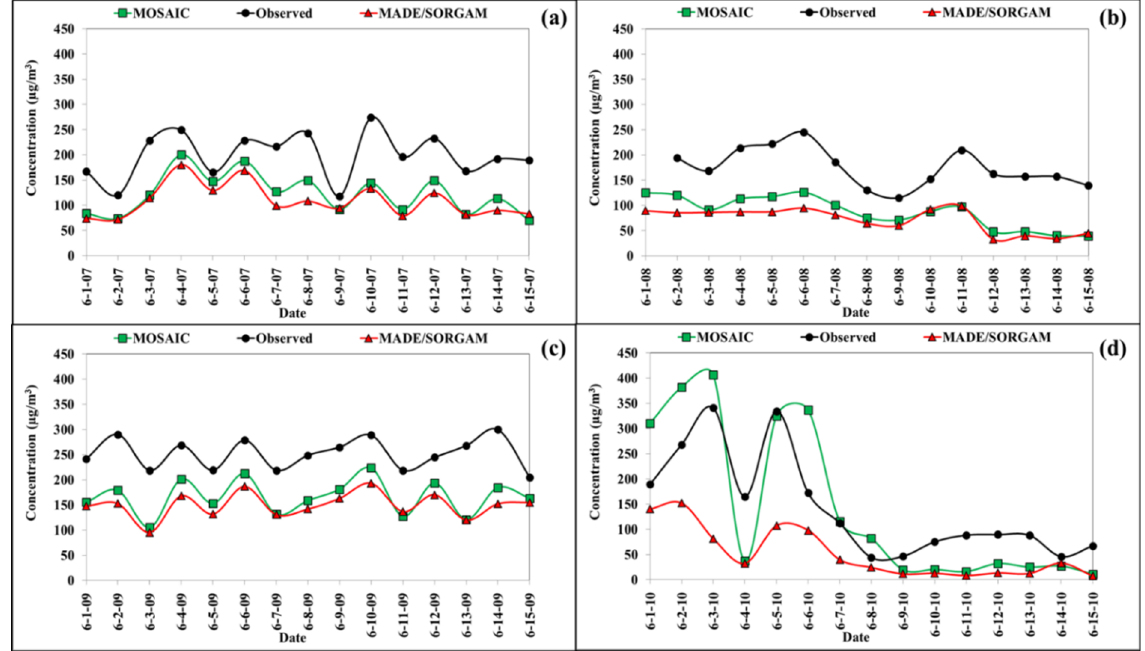
Figure 3. Daily averaged time-series plot of simulated PM 10 concentrations with MADE/SORGAM aerosol module (red) and MOSAIC aerosol module (green) against observed PM 10 levels (black) for years ( a ) 2007, ( b ) 2008, ( c ) 2009 and ( d ) 2010 over Delhi.